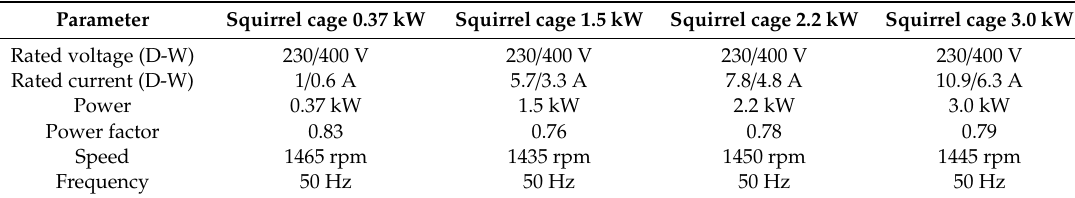
Table 5. Machine characteristics.